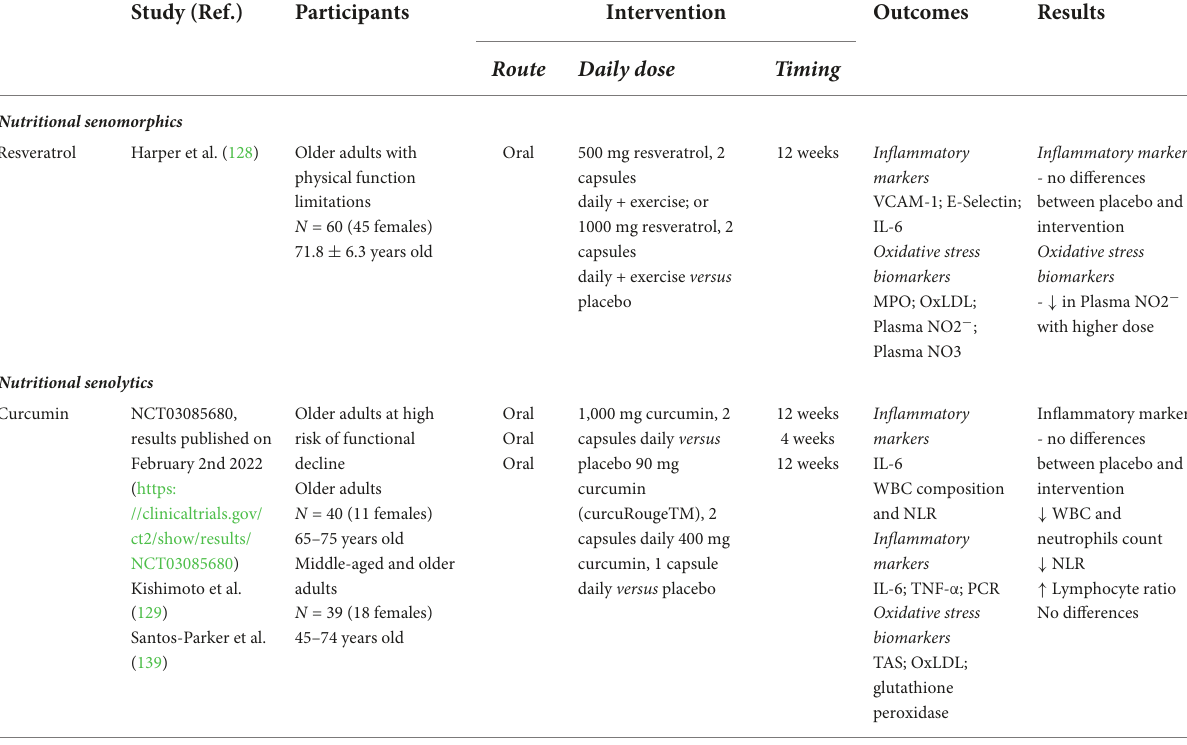
TABLE 3 Clinical trials completed evaluating nutritional senotherapeutics on immunosenescence, cellular and humoral components, and markers of inflammation and oxidative stress in aged individuals. Study (Ref.)